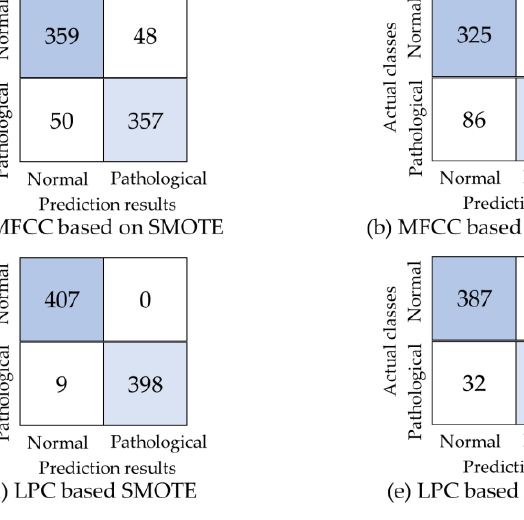
Figure 9. The confusion matrices produced by the CNN on the class-balanced dataset under various conditions.